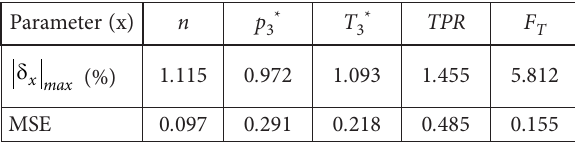
Table 5. Relative and mean squared errors of simulated results